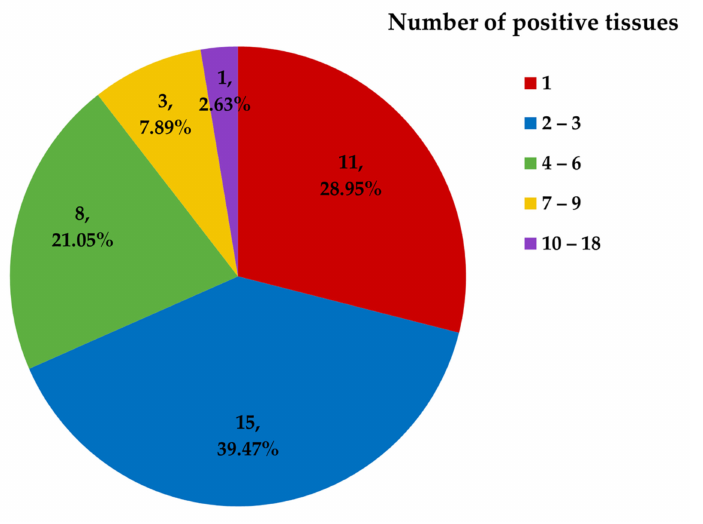
Figure 1. Classification of positive animals according to the number of tissues in which HV DNA was detected. Numbers of animals and percentage of all positive animals within each group are